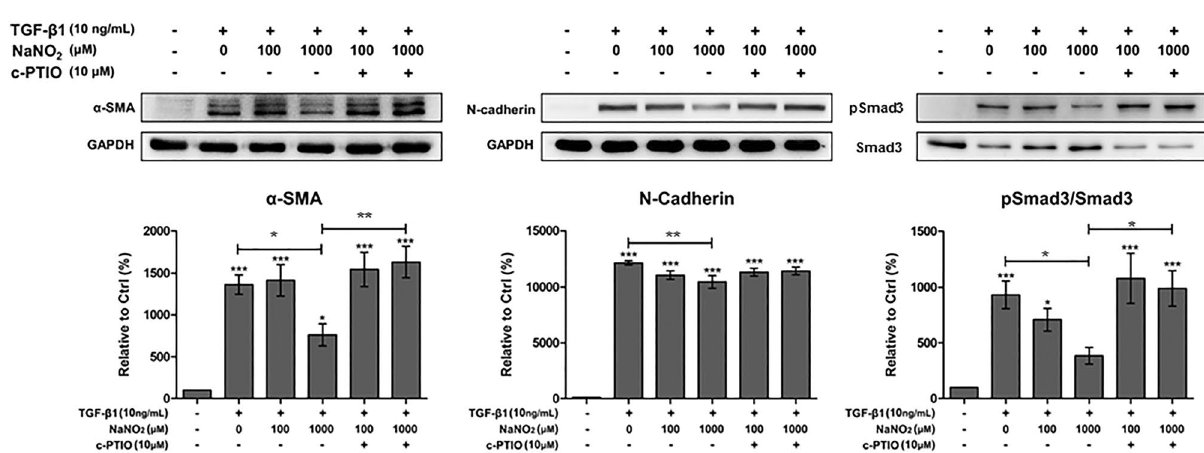
Figure 7. The effect of NO on TGFβ1-stimulated keratocytes. αSMA and N-cadherin expression in TGFβ1- stimulated keratocytes significantly decreased after 1000 μM sodium nitrite treatment for 24 h. However, lower concentration (100 μM) of sodium nitite showed little effect. Smad3 phosphorylation was also decreased after 1000 μM sodium nitrite treatment for 24 h. Addition of 2-4-carboxyphenyl-4,4,5,5-tetramethylimidazoline-1- oxyl-3-oxide (cPTIO, 10 μM) in the culture medium reversed the effect of NO. Statistical analysis was performed by setting the expression level in TGFβ1-stimulated keratocytes with no NO treatment as the baseline. Note that only the bands at the adequate molecular weights were shown here. Full length gel and blots are included in the supplementary information. *p < 0.05, **p < 0.01, ***p <